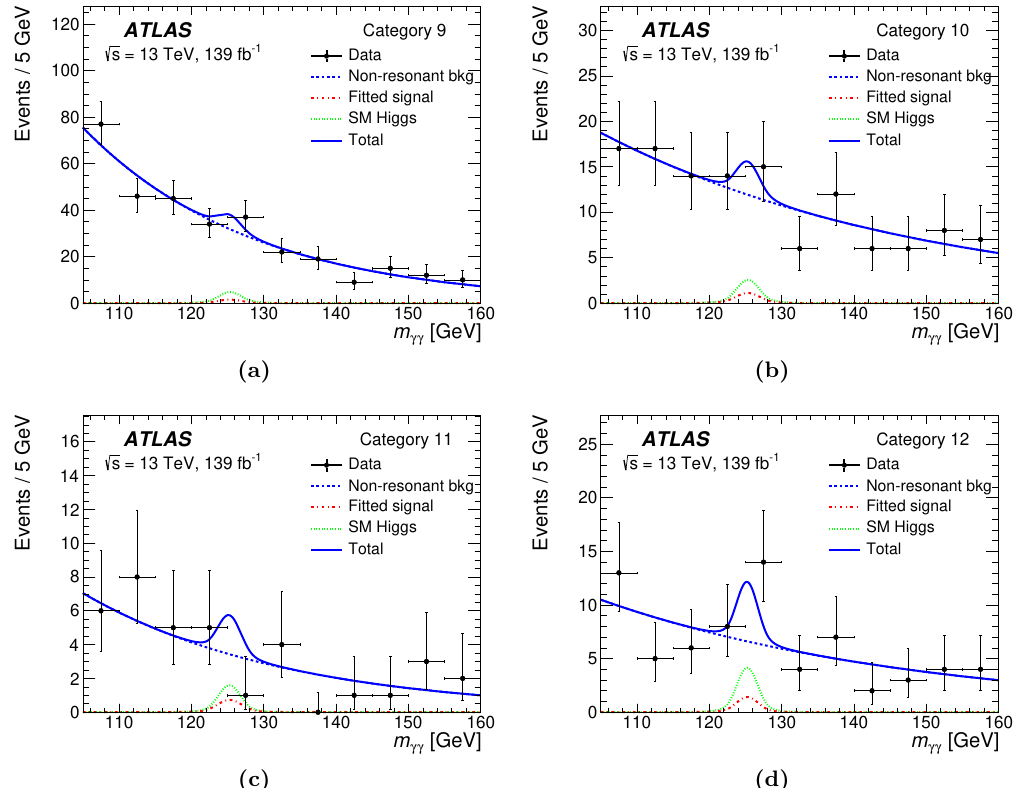
Figure 6 . Diphoton invariant mass spectra and the corresponding (cid:12)tted signal and background in the Rest categories (a) 9, (b) 10, (c) 11, and (d) 12. The signal samples shown correspond to ! W (cid:6) ~ (cid:31) 0 the ~ (cid:31) (cid:6) ~ (cid:31) 0 h ~ (cid:31) 0 signal with m (~ (cid:31) (cid:6) = ~ (cid:31) 0 ) = 200 GeV and m (~ (cid:31) 0 ) = 0 : 5 GeV. The non-resonant 1 2 1 1 1 2 1 background (dashed curve), the SM Higgs boson (dotted curve), and the signal (dash-dotted curve) are obtained from a simultaneous signal-plus-background (cid:12)t to the full m (cid:13)(cid:13) spectrum for the 12 categories. The total of these contributions is shown by the solid